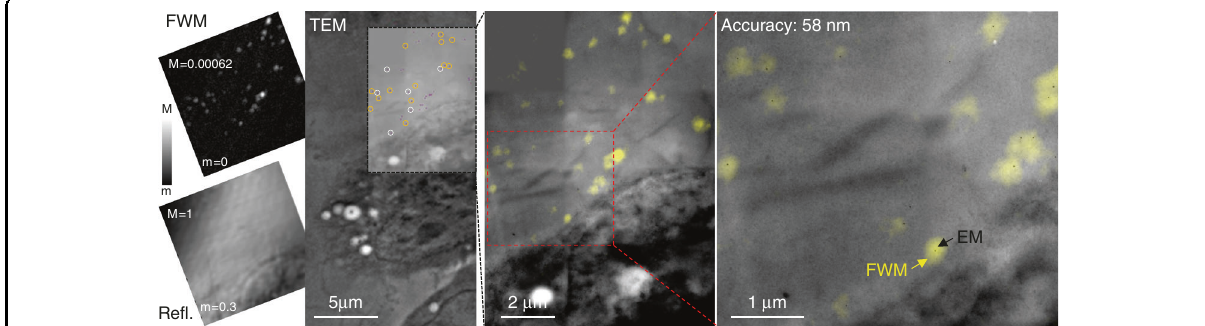
Fig. 5 CLEM correlation accuracy with 5nm-radius AuNPs. HeLa cells incubated with 5nm-radius AuNPs bound to the EGF protein. Individual AuNPs are detected background-free in FWM (left) measured on 300 nm thin resin sections post-cell fi xation, ready for EM analysis. The confocal re fl ection image simultaneously acquired with FWM is shown below (linear grey scales are from m to M as indicated; M = 1 correspond to 65 mV rms detected, see Methods for details of the excitation and detection conditions). A large overview TEM of the same region is shown. On the area indicated by the black dashed frame, a series of high resolution EM images were taken and stitched together. Individual AuNPs are highlighted by the circles. The overlay between FWM (yellow) and TEM (grey) is shown on the centre and further zoomed into the indicated red dashed area on the right side (contrast adjusted to aid visualisation). For the correlation analysis, of the 19 individual AuNPs highlighted by the circles, 6 (white circles) were discarded as being of focus. The FWM image was transformed into the EM reference system using a linear transformation matrix that accounts for translation, rotation, shear and scaling of axes. On the right side, individual AuNPs identi fi ed in FWM (yellow spots) are seen in EM (black dots). The correlation accuracy is